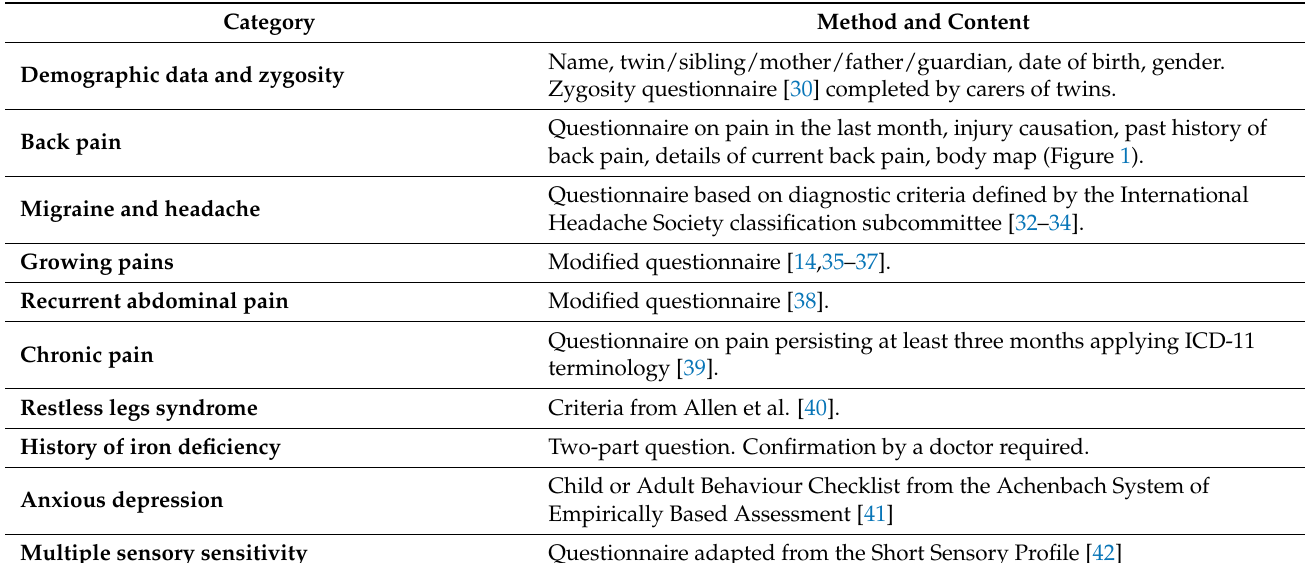
Table 1. Summary of questionnaire content (paper or online).